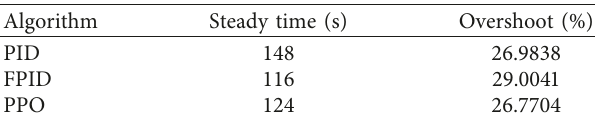
Figure 11: Simulation curve of steam pressure from 100%FP to 70%FP. Table 3: Performance indicators of the three algorithms when the load decreases from 100% to 70%.